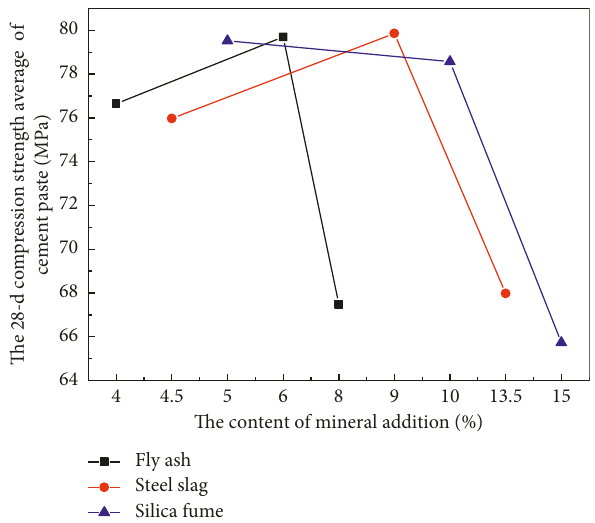
Figure 12: The relationship curve between the 28-day compression average and added mineral